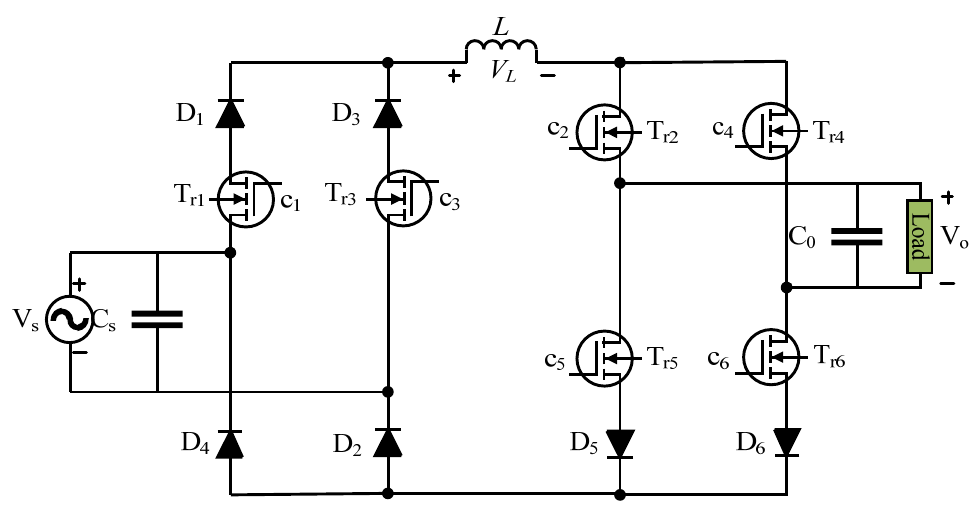
Figure 2. Proposed circuit.